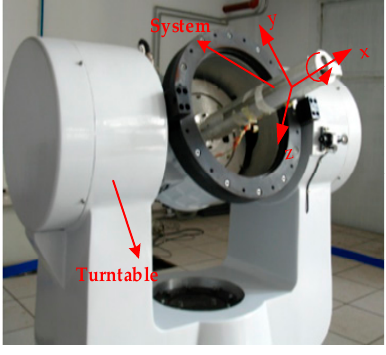
Figure 5. RSSINS installation on three-axis flight simulator.